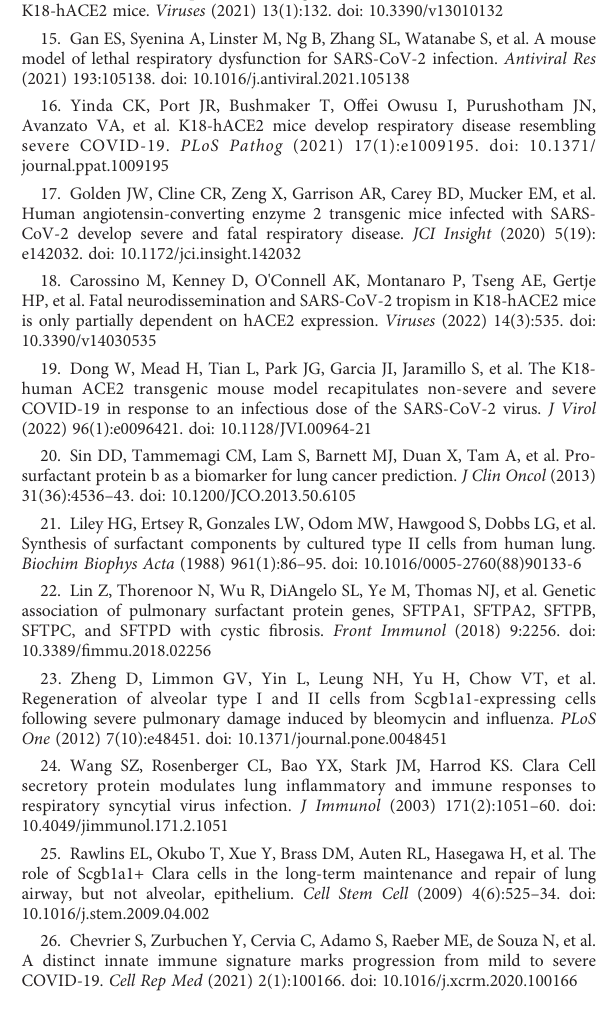
PTPRC + cells (A) , CD3 + cells (B) , neutrophil (C) , and F4/80 + macrophage (D) distribution in the lungs con fi rmed by immunohistochemistry. Each marker is stained brown and counterstained by DAPI (blue). SUPPLEMENTARY FIGURE 5 Immunohistochemistry analysis of SARS-CoV-2 infectious target lung cells in K18-hACE2, SFTPB-hACE2, and SCGB1A1-hACE2 mice. N protein of SARS-CoV-2 (red) and lung cell type markers are double stained: (A) type I alveolar cell marker AGER, (B) type II alveolar cell marker LAMP3, (C) club cell marker SCGB1A1, (D) ciliated cell marker acetylated alpha-tubulin, (E) pulmonary neuroendocrine cell marker chromogranin A, and (F) epithelial goblet cell marker MUC5AC. SUPPLEMENTARY FIGURE 6 SARS-CoV-2 particles detected in the lungs of K18-hACE2 and SCGB1A1- hACE2 mice. SARS-CoV-2 particles detected by electron microscopy. In K18-hACE2 mice, viral particles (black arrow heads) were distributed in type I alveolar pneumocytes (A) . The dotted line is the type II alveolar pneumocyte. M, mitochondria; LB, lamellar body. In SCGB1A1-hACE2 mice, SARS-CoV-2 is bound to the cilia in bronchos (B) .